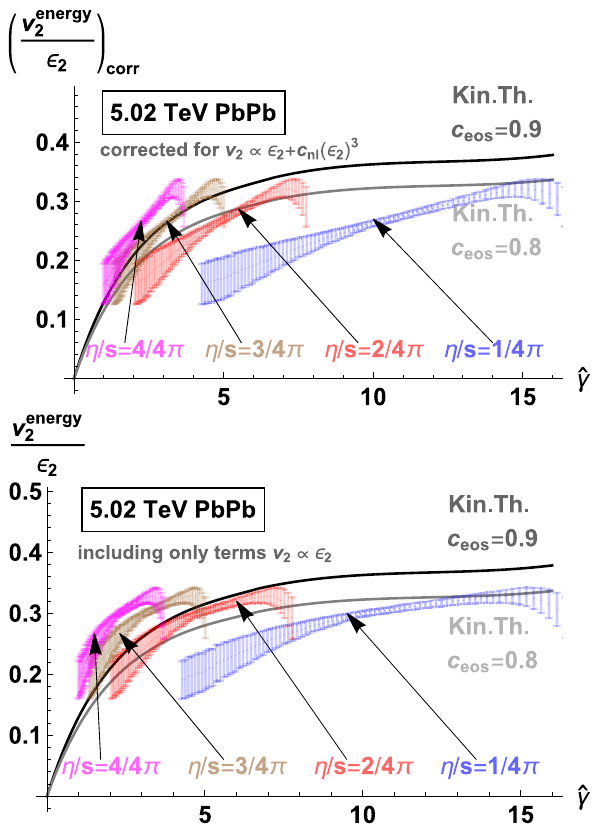
Fig. 10 The ratio v 2 /(cid:17) 2 as a function of ˆ γ . Results for kinetic theory, supplemented by a factor c eos = 0 . 8 and 0 . 9 to correct for a non- ideal equation of state, are compared to ratios v 2 /(cid:17) 2 ( ˆ γ) constructed from ALICE data. Uncertainty bands arise from uncertainties in the centrality-dependent eccentricity only. Non-linearities f corr ((cid:17) 2 ) in the (cid:17) v 2 -dependence of 2 are corrected for according to Eq. (39) (upper plot). To illustrate the size of this necessary correction, the lower plot shows results for the case that it is neglected ( f corr ((cid:17) 2 ) = 1)